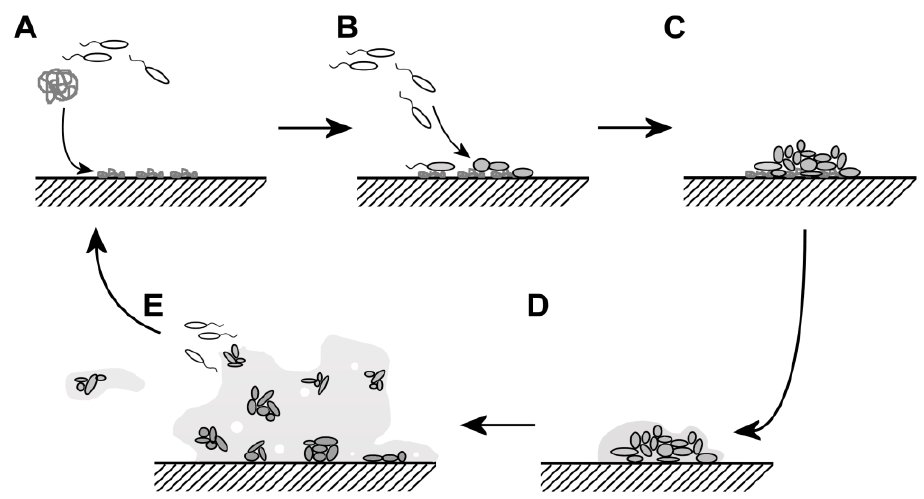
Figure 1. Schematic representation of biofilm formation. ( A ) Proteins from the patient rapidly adsorb onto the surface of an implanted device and form a good substrate for planktonic, free-swimming bacteria to adhere to. ( B ) The sessile bacteria will recruit additional bacteria from the direct environment and also proliferate on the surface. ( C ) The adhered bacteria change gene expression patterns and start producing the extracellular polymeric substance, the main component of the biofilm. ( D ) The biofilm slowly grows and microcolonies of bacteria form inside the biofilm. ( E ) Finally, small parts of the biofilm can break off and planktonic bacteria escape from the biofilm and can invade new, clean surfaces at distant